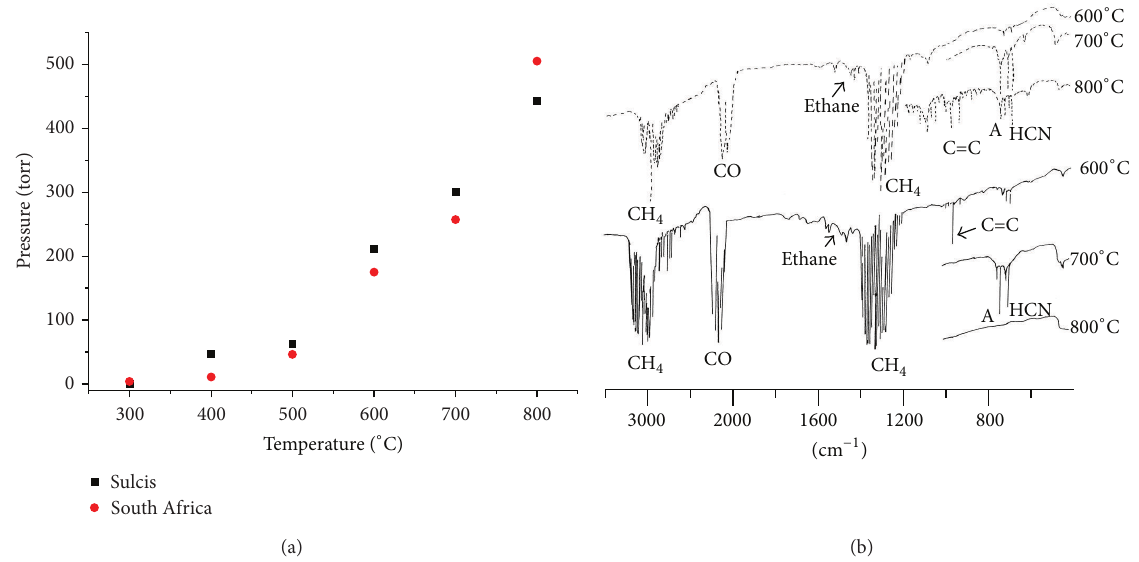
Figure 7: (a) Plots of the pressure values of noncondensable gases against temperatures for Sulcis and South Africa coals. (b) FT-IR spectra in 3500–400 cm −1 region of noncondensable gases obtained at various temperatures by Sulcis (—) and South Africa coals (---). A =